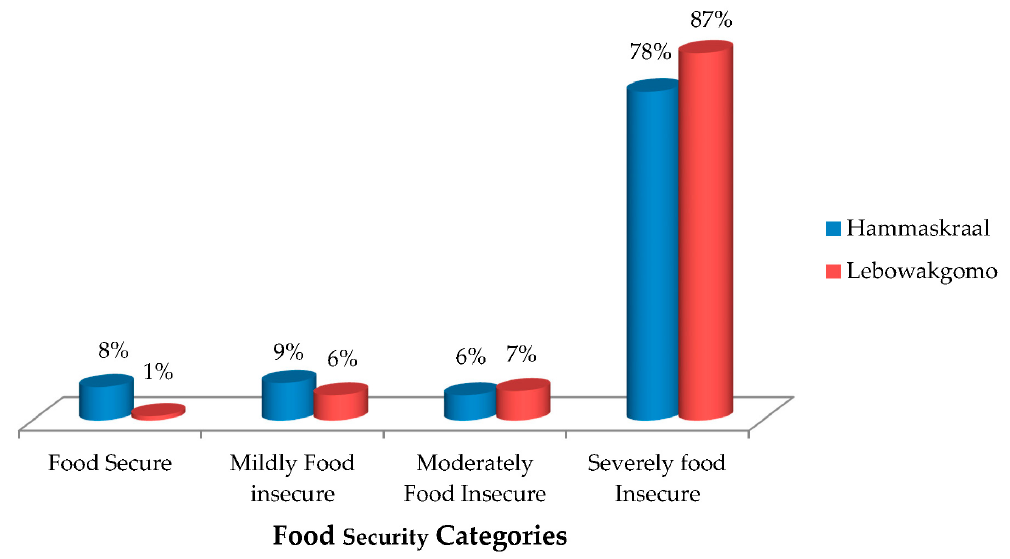
Figure 1. Children’s food security categories as determined by the Children Food Insecurity Access Scale Scale (CFIAS).